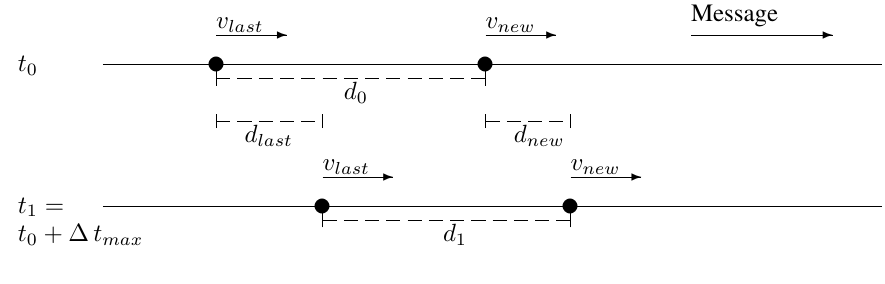
Figure 4. Case 2 depiction.